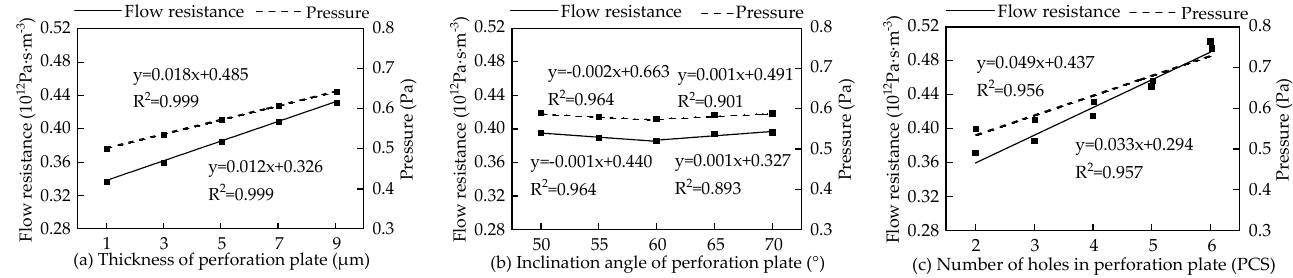
Figure 8. Flow resistance trends of the scalariform perforation plate structure.